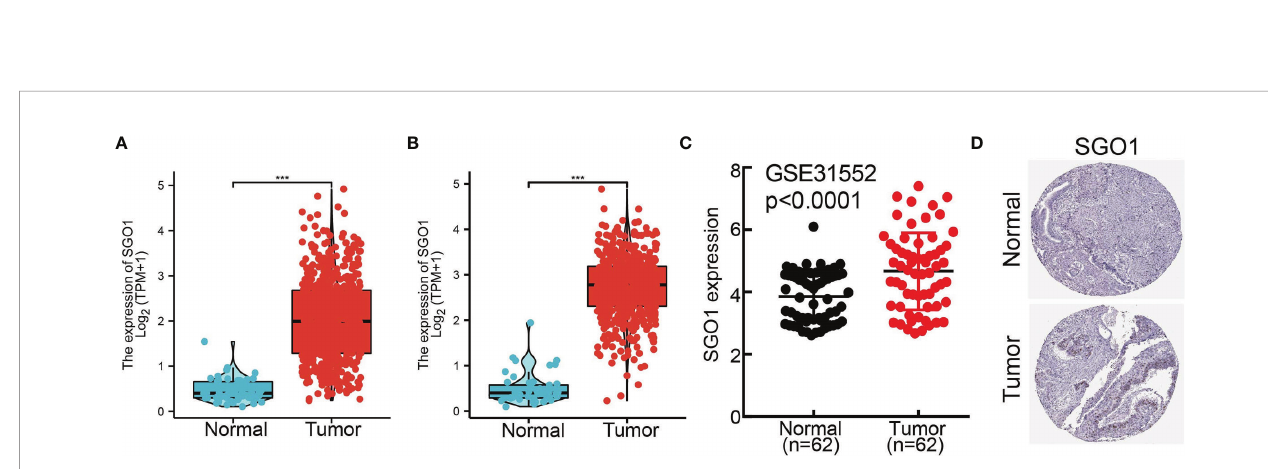
FIGURE 2 | SGO1 was highly expressed in LUAD. (A, B) SGO1 was overexpressed in LUAD and LUSC examined by TCGA. (C) Relative SGO1 expression examined by the GEO dataset. (D) The protein level of SGO1 in lung cancer was determined by the HPA database. ***P <